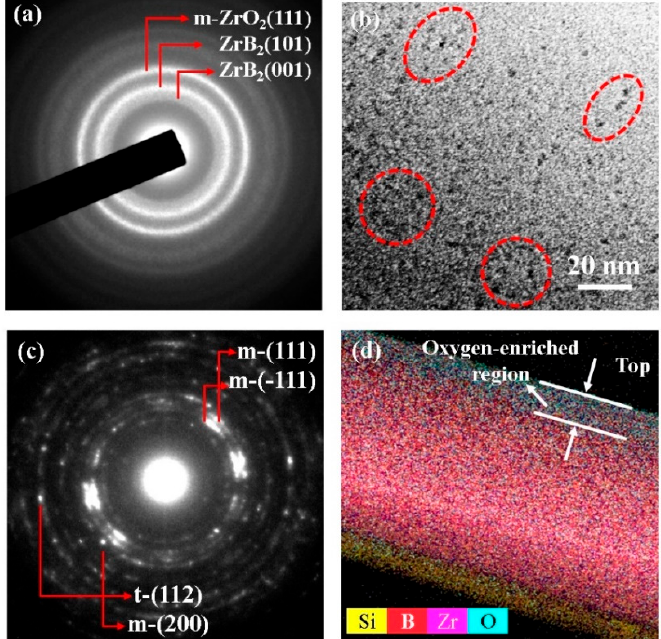
Figure 8. ( a ) SAED patterns and ( b ) TEM image of Zr-B-O nanocomposite film at 120 W sputtering power of the ZrB 2 target, and ( c ) SAED patterns and ( d ) elemental mapping image of Zr-B-O nanocomposite film at 120 W sputtering power of ZrB 2 target after 850 °C oxidation for 1 h.